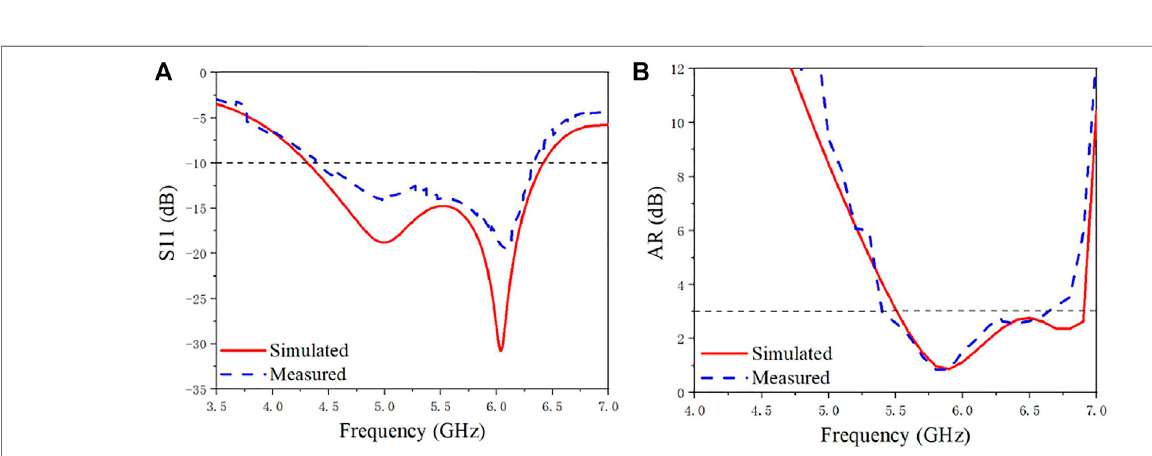
11 and ARBW of the proposed antenna: